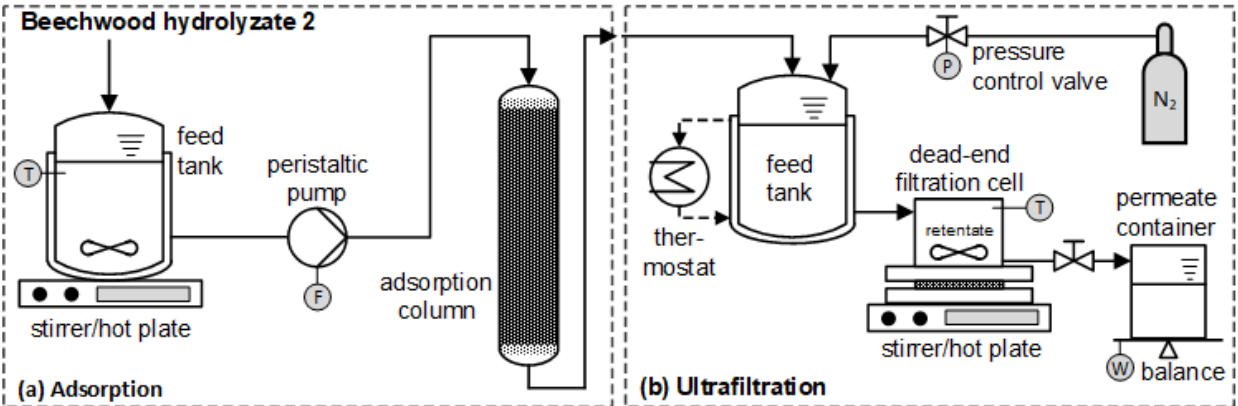
Figure 3 . Schematic diagram of the experimental setup for ( a ) adsorption and ( b ) ultrafiltration . Figure 3. Schematic diagram of the experimental setup for ( a ) adsorption and ( b )